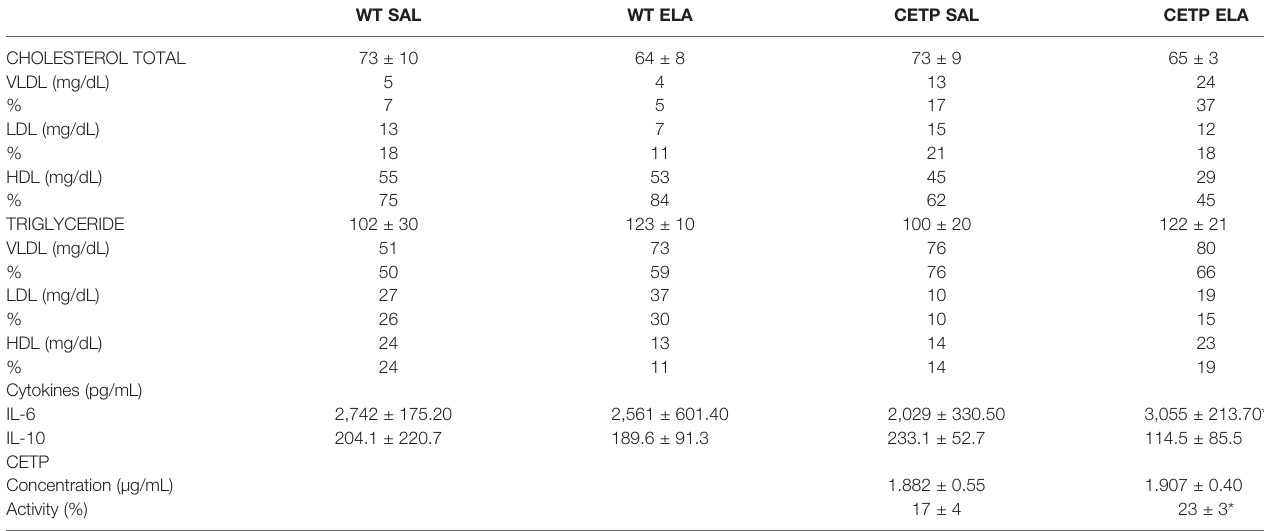
TABLE 1 | Total cholesterol (C), triglyceride (TG), lipoprotein fractions, cytokines and CETP plasma levels in WT and huCETP mice after elastase-induced emphysema (ELA), or saline (SAL). WT SAL WT ELA CETP SAL CHOLESTEROL